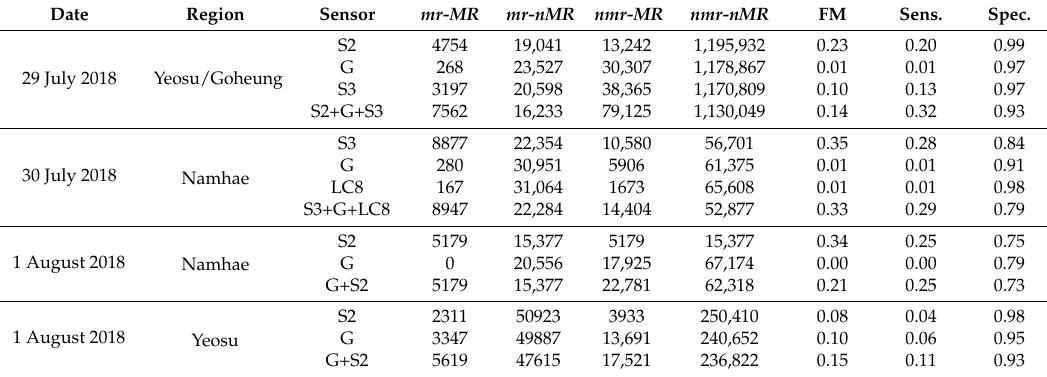
Table 6. Performance evaluation of each sensor for Yeosu, Goheung, and